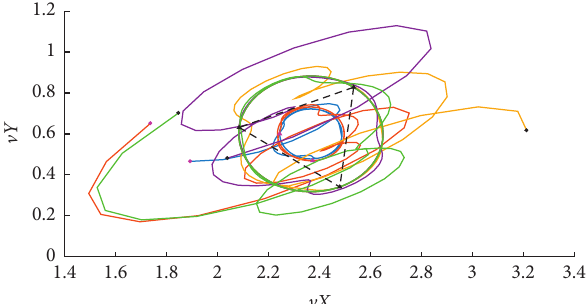
Figure 4: The trajectory of agents’ velocities over time with time